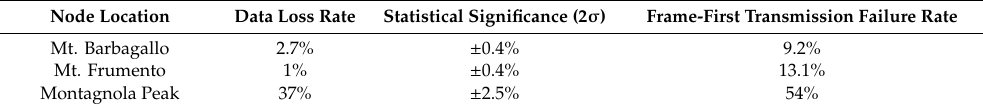
Table 1. Transmission statistics table. The data loss rate corresponds to the global amount of data not transferred to the server, while the frame-first transmission failure rate is the observed probability of the system to fail the first transmission of a frame. The significance of the loss rate is computed from the number of missing measurements under a Poisson statistics assumption (relative standard deviation at √ N 2 σ is 2/